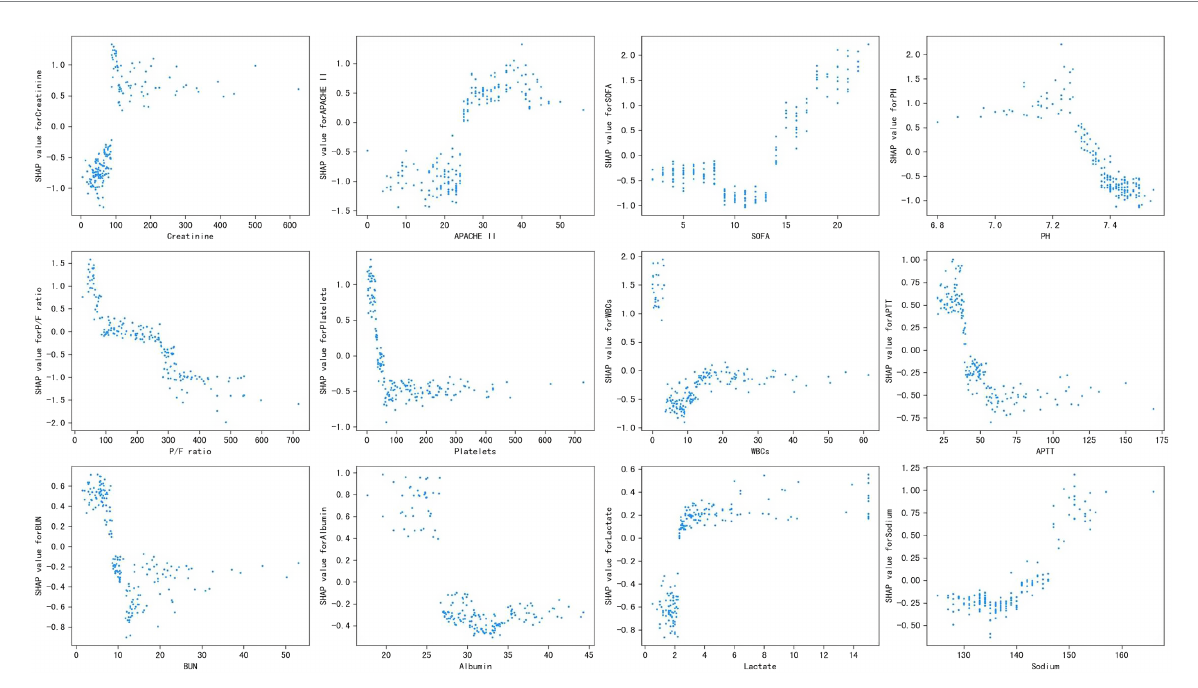
FIGURE 3 Partial SHAP dependence plot of the XGboost model. It shows how a single feature (the top 12 important variables) affects the output of the XGBoost predictive model. SHAP values for specific features exceed zero, representing an increased risk of death. APACHE II, Acute Physiology and Chronic Health Evaluation II; SOFA, Sequential Organ Failure Assessment; P/F, PaO 2 /FiO 2 ; WBCs, white blood cells; APTT, activated partial thromboplastin time; BUN, blood urea